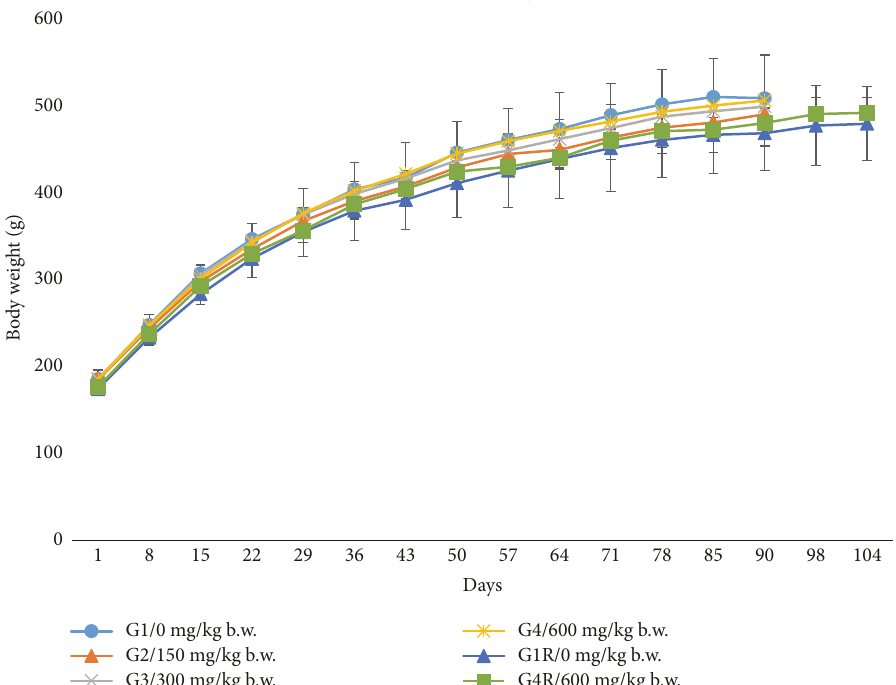
Figure 4: Effect of ubiquinol acetate on body weights in male rats. Mean body weights for male rats during a 90-day oral (gavage) toxicity study. The values are presented as means ± standard deviation (10 rats/sex/group for main study group and 5 rats/sex/group for recovery